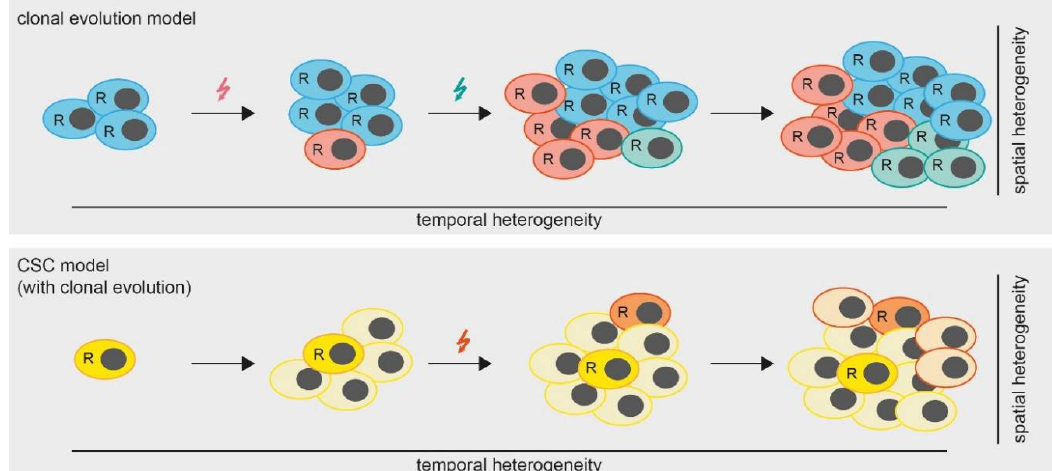
Figure 2. Models of tumor heterogeneity. In the clonal evolution model (upper panel) all cells are able to replicate (indicated by “R”). Mutations (colored arrows) are gained over time, leading to the formation of subclones which results in a heterogeneous tumor. In the cancer stem cell (CSC) model with clonal evolution, only CSCs are able to replicate. However, mutations occurring over time lead to the formation of additional CSCs.